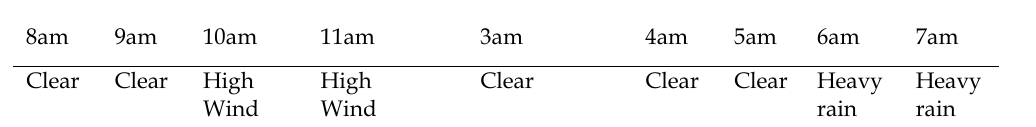
Table 3. An example of a 24hr window weather